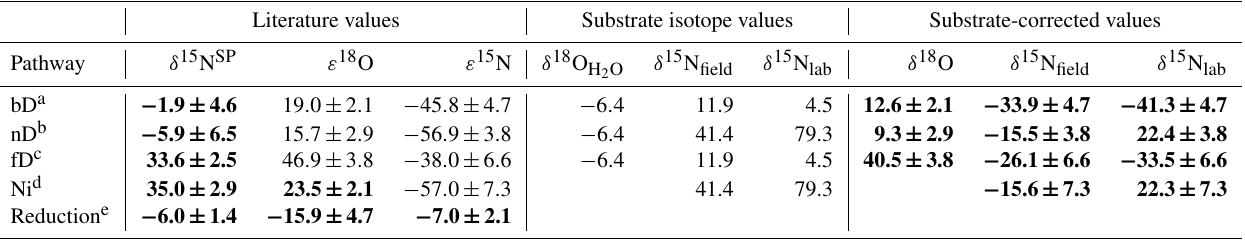
Table 1. Summary of mixing endmember isotopic signatures of particular pathways (bD – bacterial denitrification, nD – nitrifier denitrifica- tion, fD – fungal denitrification, Ni – nitrification) and reduction fractionation factors (reduction) with respective references. For the model input, each value is corrected with the respective mean isotopic signature of the substrate: for δ 18 O – soil water ( δ 18 O H ) for bD, nD, and 2 O fD; for δ 15 N – respective substrate – NO − for bD and fD; and for NH + for nD and Ni, with distinct values applied for field ( δ 15 N field for F1, 3 4 F2, and F3) and laboratory ( δ 15 N lab for L1, L2) studies. The respective substrate-corrected values were applied as a model input for δ 18 O and δ 15 N; for δ 15 N SP no substrate correction is needed. The final model input values are marked with bold font. Literature values Substrate isotope values Substrate-corrected values